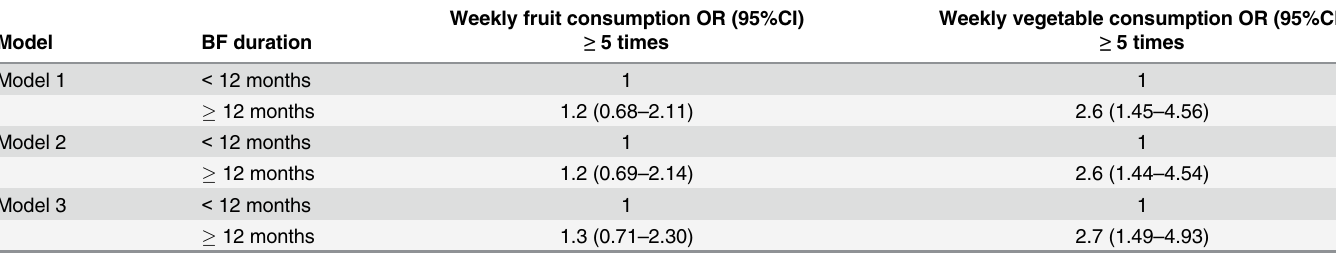
Model 1: not adjusted; Model 2: adjusted for intervention; Model 3: adjusted for intervention, child's age and gender, mother's educational level, cohabitation with the maternal grandmother, and number of